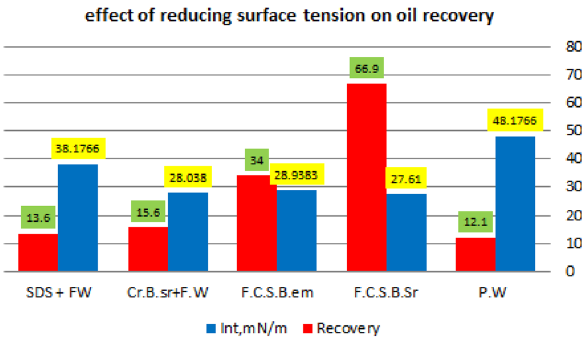
Fig. 11 Effect of surface tension on oil